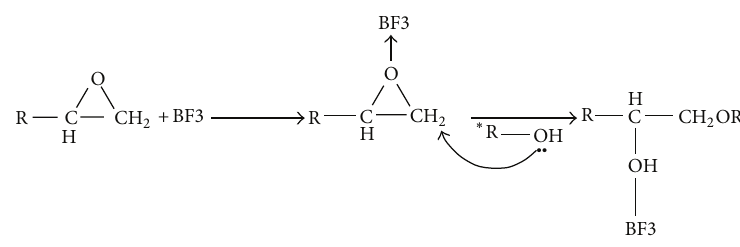
Scheme 4: Mechanism of Lewis acid-catalyzed curing of epoxy by alcohol.